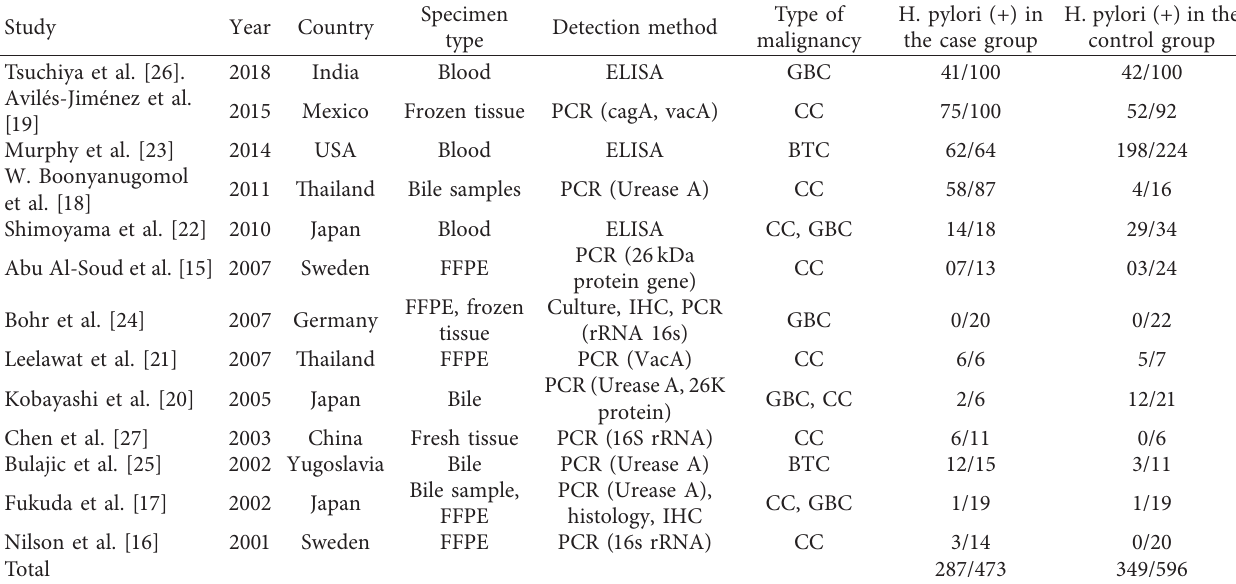
FFPE: formalin-fixed paraffin-embedded tissues, IHC: immunohistochemistry, ELISA: enzyme-linked immunosorbent assay, PCR: polymerase chain re- action, H. pylori: Helicobacter pylori, Cag A: cytotoxin-associated gene A, Vac A: Vacuolating cytotoxin A, CC: cholangiocarcinoma, GBC: gall bladder cancer, and BTC: biliary tract